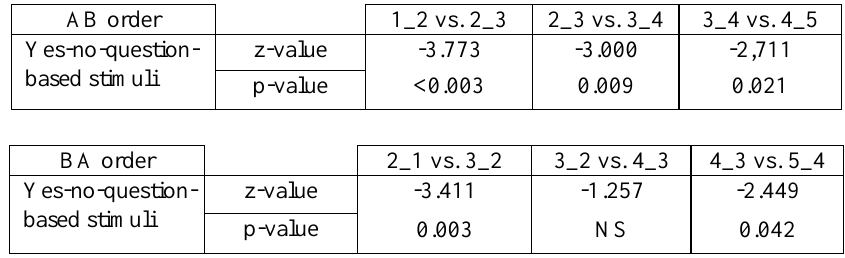
Table VI. z- and p-values of three Wilcoxon matched pairs signed rank tests for each order of presentation comparing the “different” response rate between adjacent pairs for yes-no-question-based stimuli.